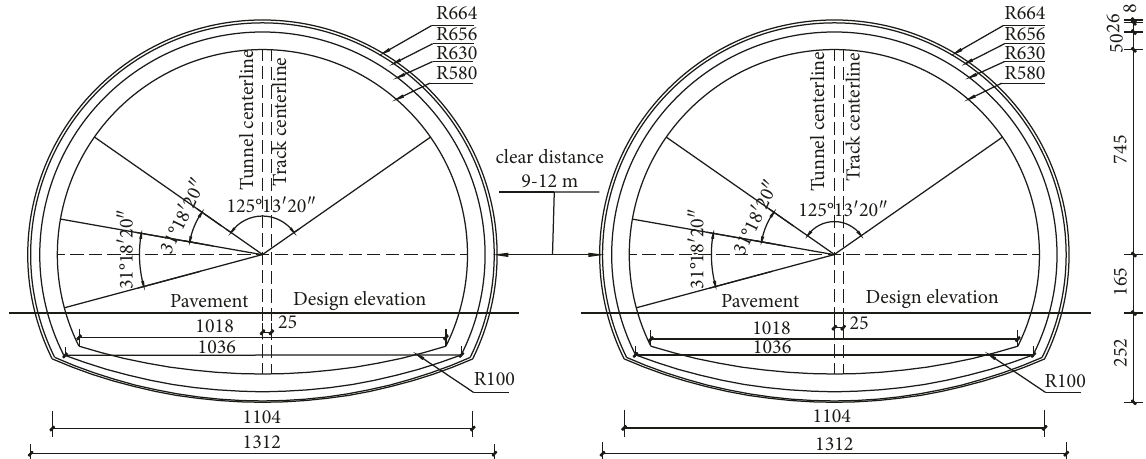
Figure 1: Design drawing of tunnel clear distance